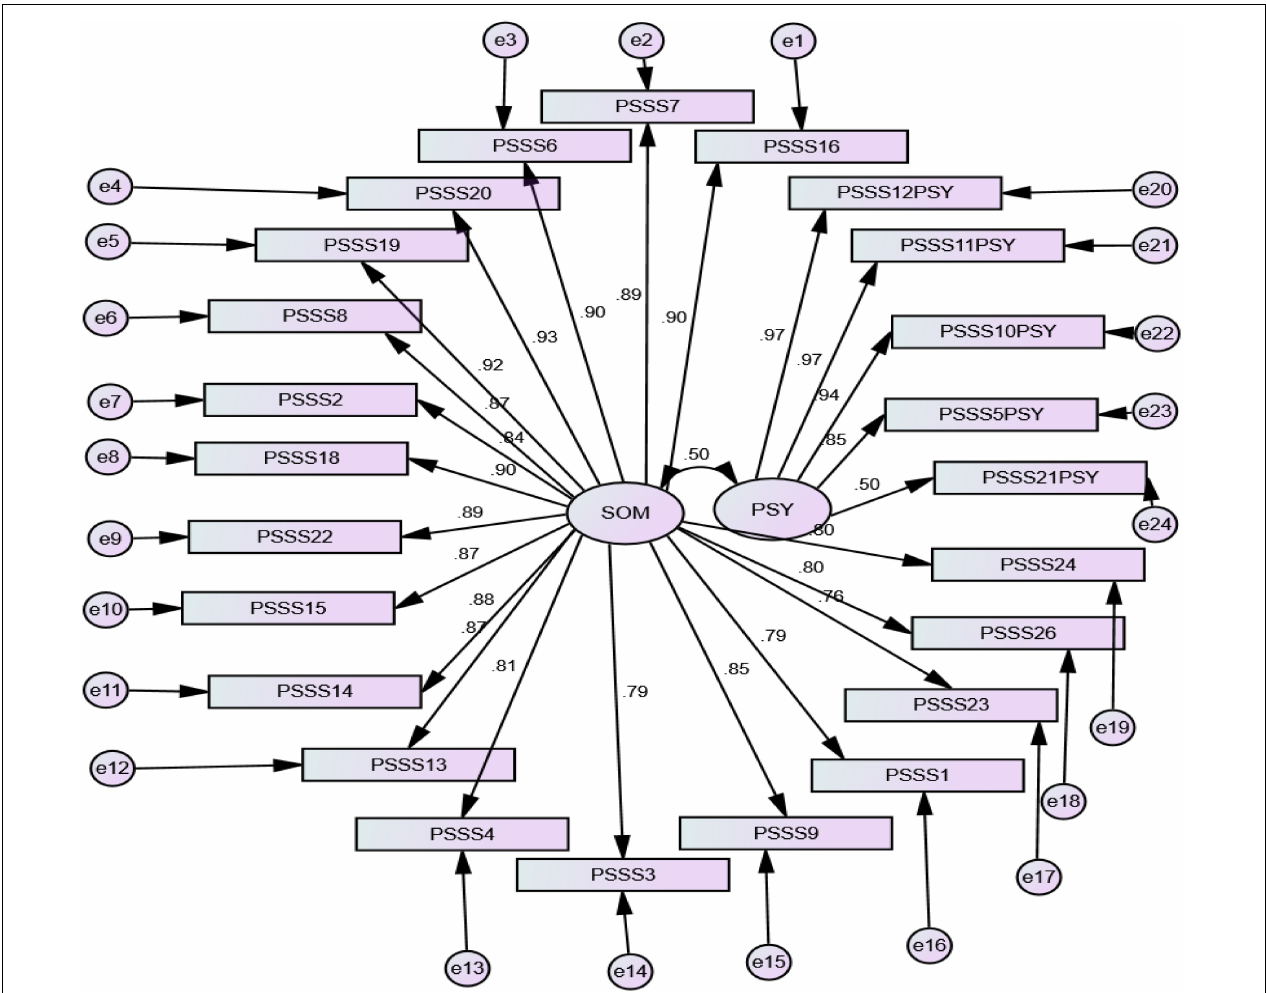
FIGURE 1 | The confirmatory factor analysis of two subscales of Psychosomatic Symptoms Scale (PSSS). Som, somatic complaint; Psy, psychological